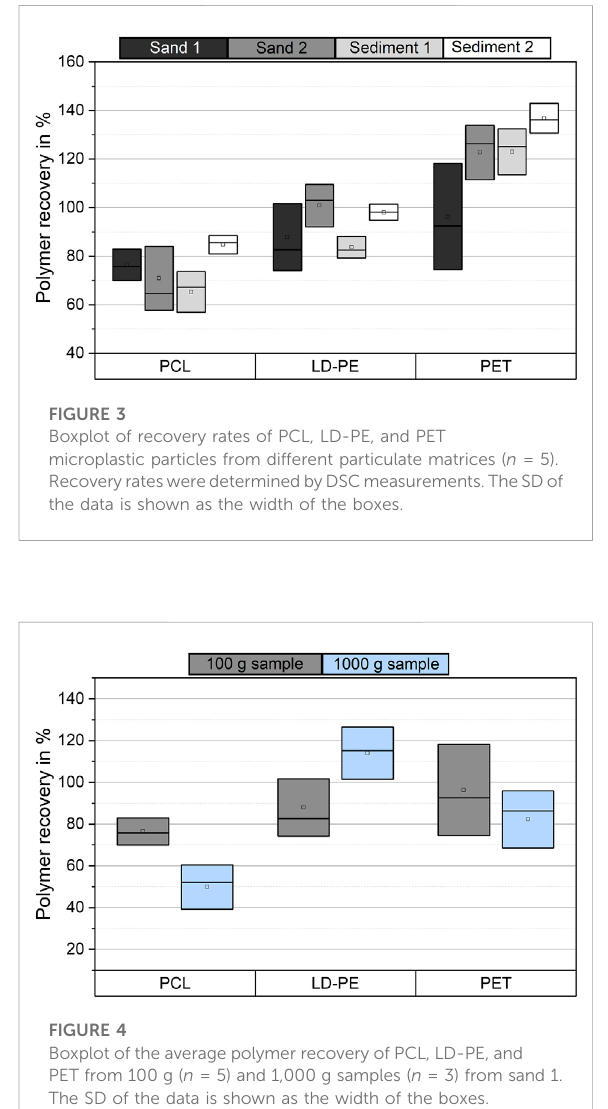
FIGURE 4 Boxplot of the average polymer recovery of PCL, LD-PE, and PET from 100 g ( n = 5) and 1,000 g samples ( n = 3) from sand 1. The SD of the data is shown as the width of the